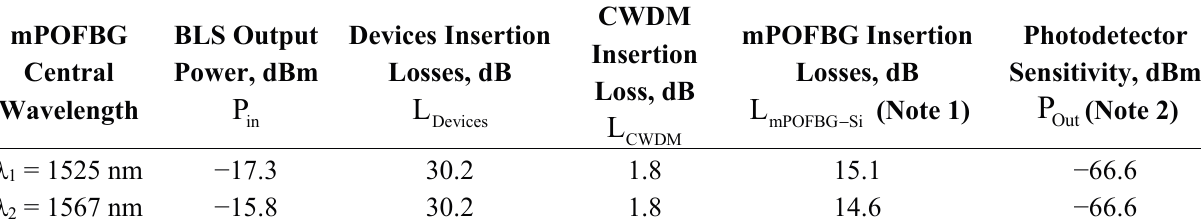
Table 1. Optical power budget analysis of the proposed hybrid silica-POF WDM remote sensing scheme.